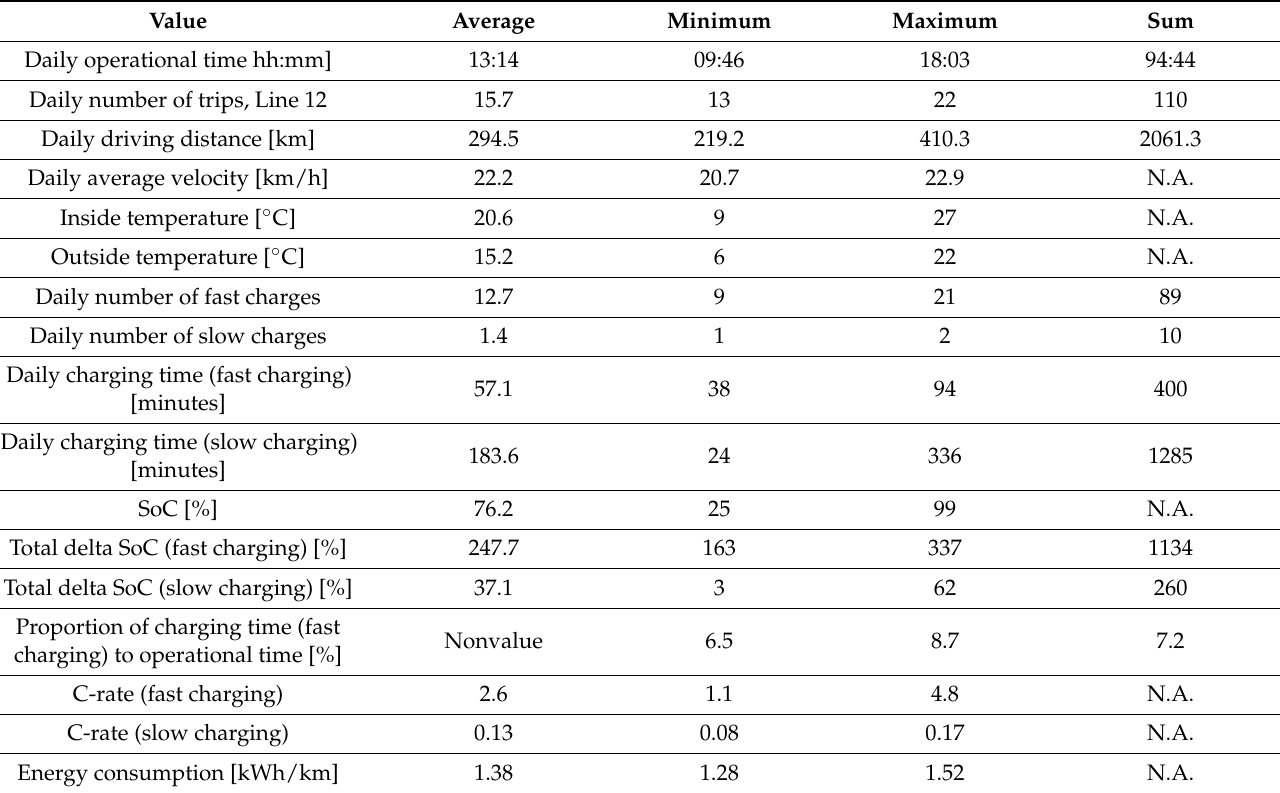
Table 7. Total operational parameters values Trondheim 15 June 2021 to 22 June